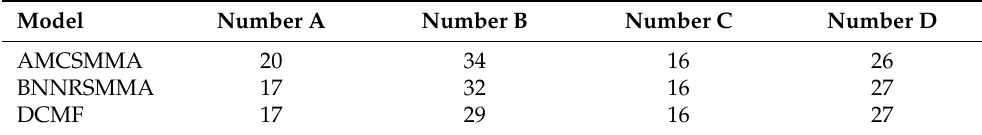
Table 9. The number of confirmed SM–miRNA associations in the top 20/50 associations predicted by AMCSMMA, BNNRSMMA, and